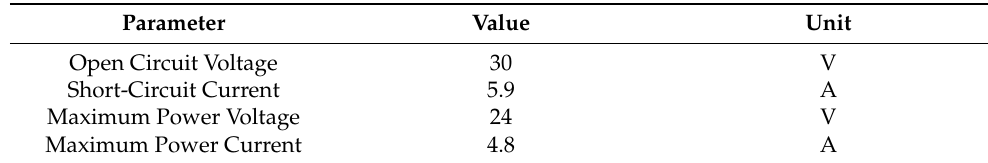
Figure 29. Voltage across the terminals of PV source 2. Table 2. PV module